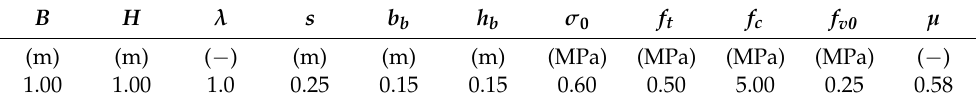
Table 4. Mechanical and geometrical properties of masonry walls for the reference